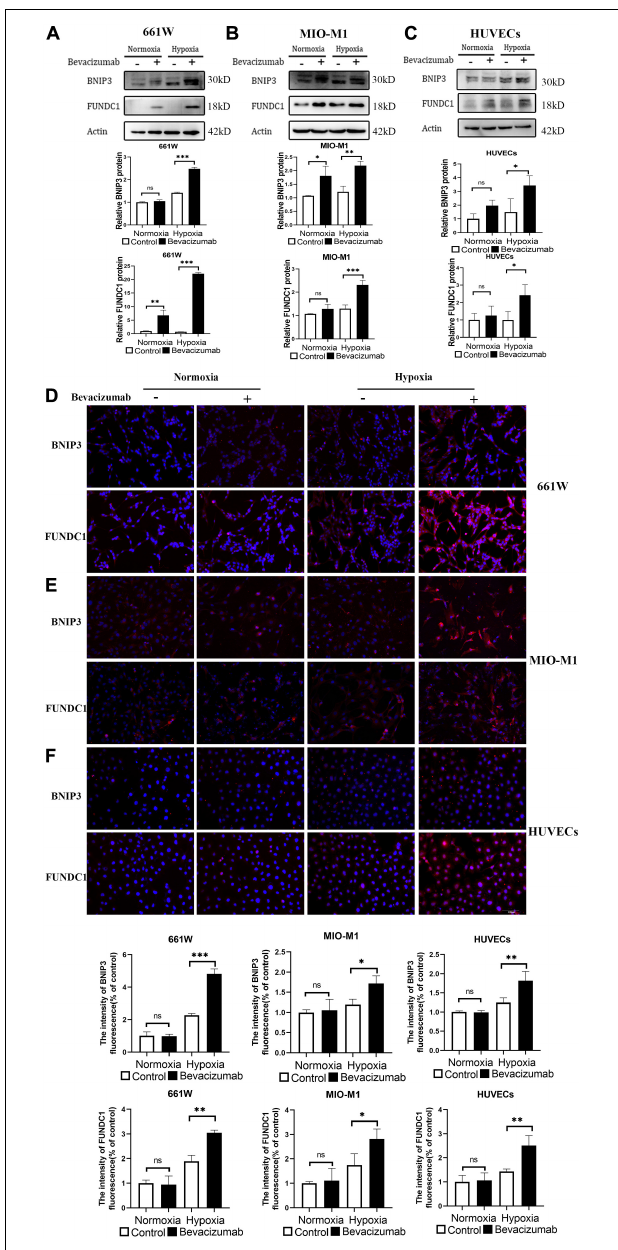
FIGURE 3 | Mitophagy-related proteins BNIP3 and FUNDC1 were upregulated by bevacizumab treatment. (A–C) Representative western blot images and densitometric results showing upregulation of BNIP3 and FUNDC1 in 661W photoreceptors, MIO-M1 Müller cells, and HUVECs following bevacizumab treatment under hypoxia which was more significant compared to normoxia. (D–F) Representative immunofluorescence images and quantification confirming that bevacizumab upregulated BNIP3 and FUNDC1 in 661W photoreceptors, MIO-M1 Müller cells, and HUVECs especially under hypoxia. Bar: 100 µ m. ns: no significance, ∗ P < 0.05, ∗∗ P < 0.01, ∗∗∗ P <